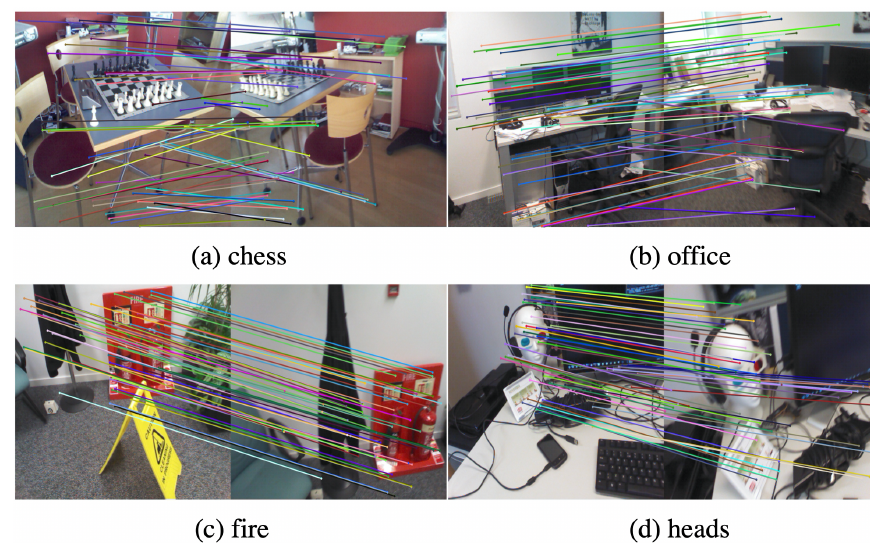
Figure 11. Schematic diagram of matching relationships in different Figure 4.12.Schematic diagram of matching relationships in different scenarios